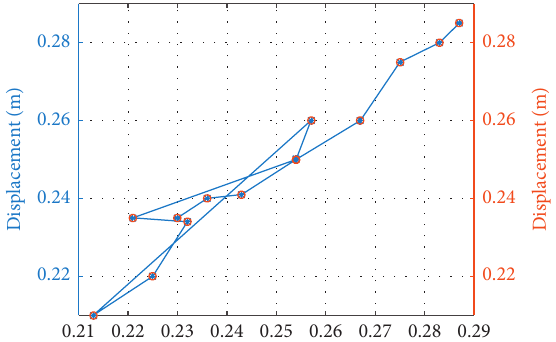
Figure 3: Displacement loading time history